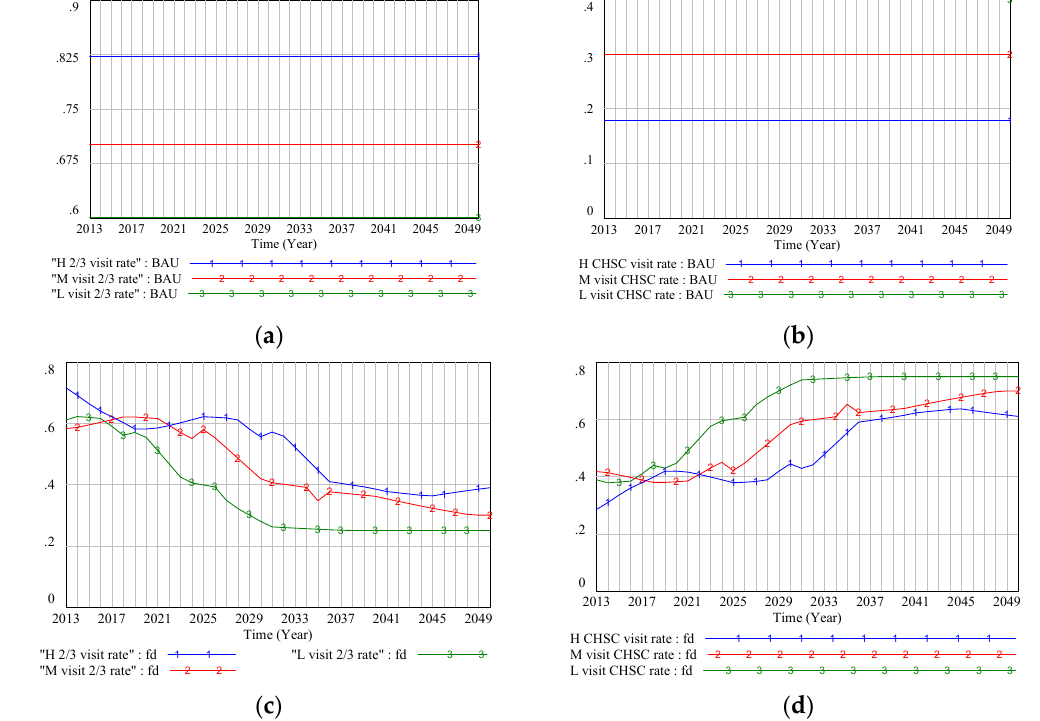
Figure 5. ( a ) Tier-3 hospital-visiting rate (BAU scenario); ( b ) community health service center (CHSC)-visiting rate (BAU scenario); ( c ) tier-2/tier-3 hospital-visiting rate (FD scenario); ( d ) CHSC-visiting rate (FD scenario). Note: BAU scenario: SES–health disparity scenario; FD scenario: SES–FD–health disparity scenario; Policy 1 scenario: scenario with intervention policy of lower